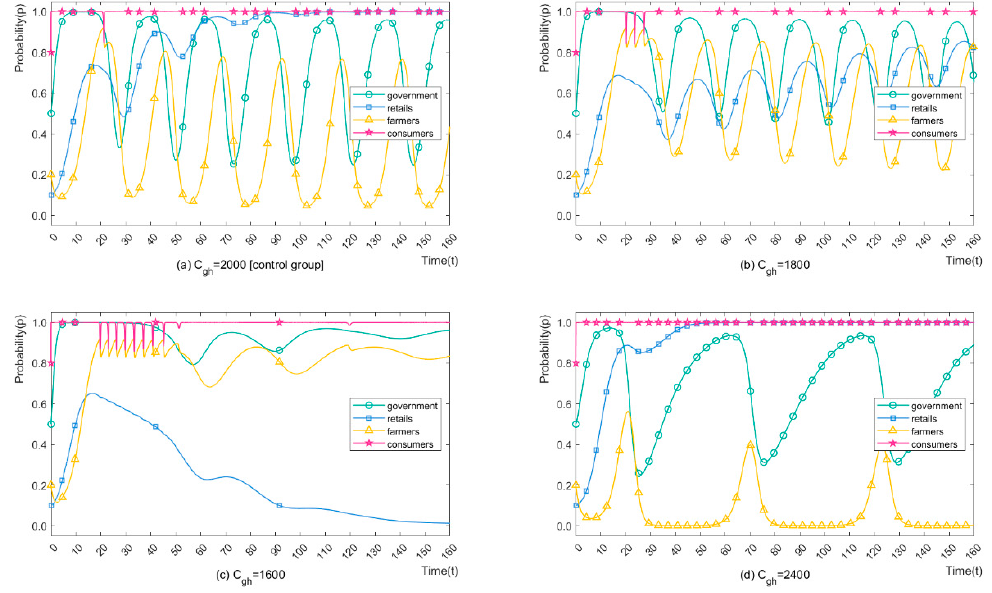
C . Figure 7. The Strategies Evolution Process of Stakeholders with Different C gh gh